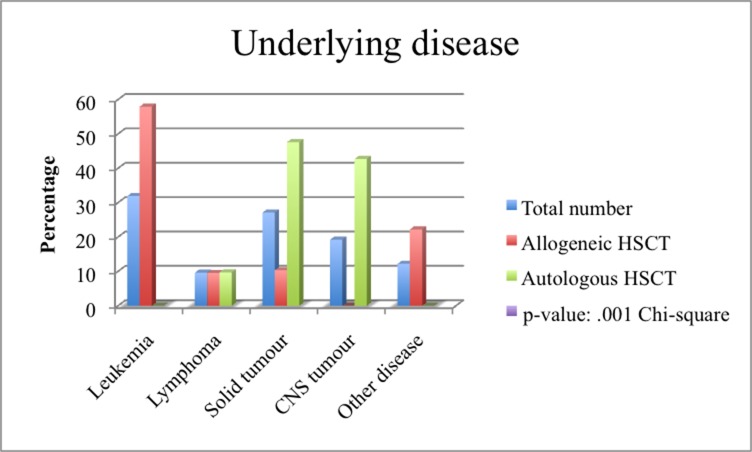
Underlying diseases in the entire cohort and a comparison between allogeneic and autologous HSCT.The distribution of underlying disease across all patients and in allogeneic and autologous patient groups is displayed as a bar chart. Statistical significant difference: p < .001 Chi2.